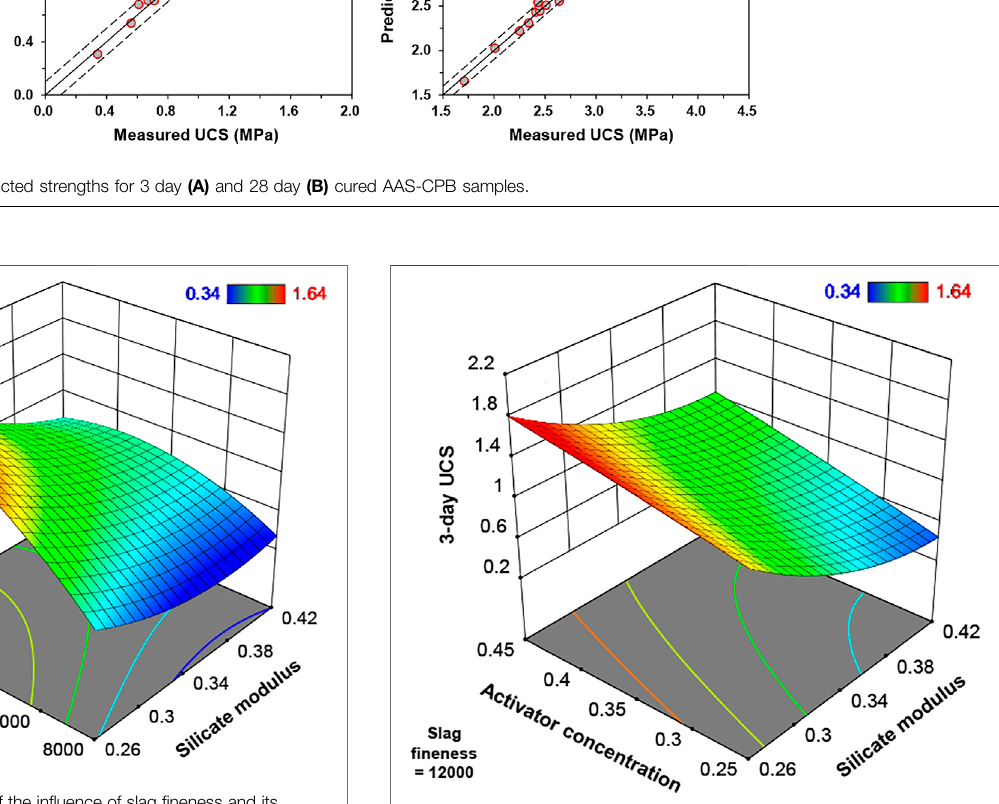
interaction with activator concentration at a fi xed slag fi neness of 12000 cm 2 /g.